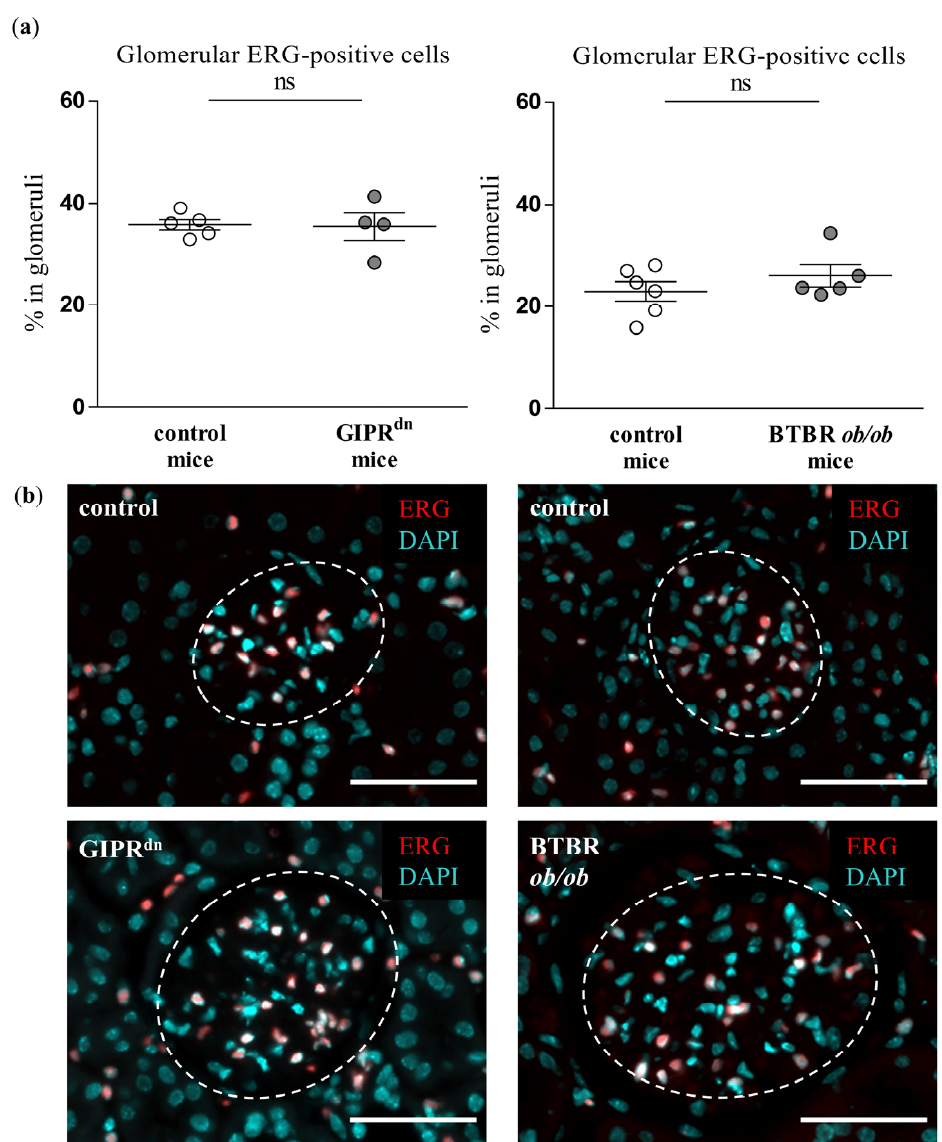
Figure 3. Analysis of the erythroblast transformation-specific related gene (ERG) in diabetic kidney disease models. ( a ) Automatic histological evaluation of ERG-positive cells in glomeruli of GIPR dn mice ( left , diabetes mellitus type 1 model) and BTBR ob/ob mice ( right , diabetes mellitus type 2 model) compared to their corresponding healthy control mice. Scatter dot plot with means and SEM, ns: not significant, n = 5–6. ( b ) Representative images of histological kidney sections stained for ERG (red) and the nuclear marker 4 ′ ,6-diamidino-2-phenylindole (DAPI, cyan). The dashed line borders the glomeruli. Scale bar: 50 µm.